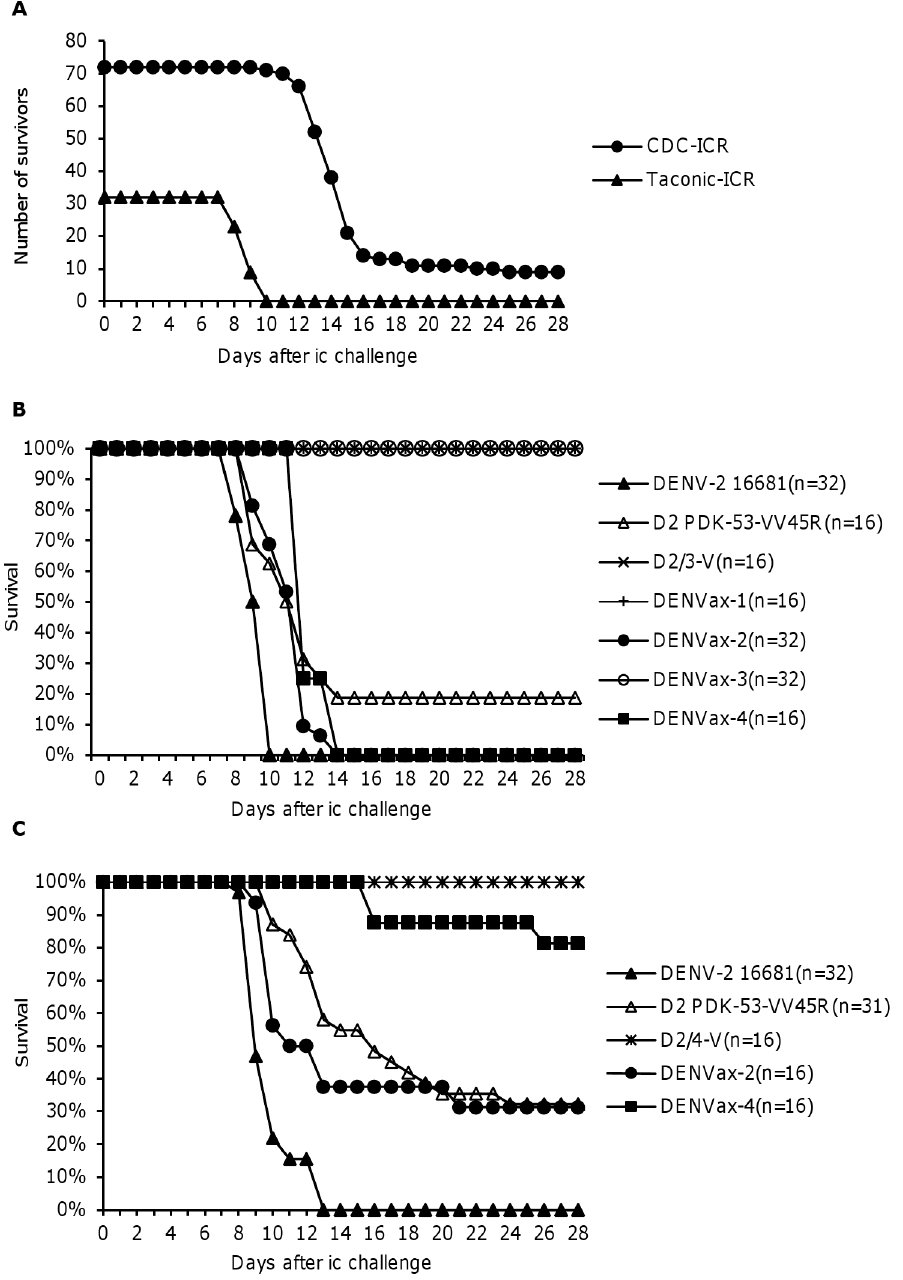
Figure 4. Neurovirulence in newborn mice. Pooled results of numerous experiments summarizing the neurovirulence of wt DENV-2 16681 virus in CDC-ICR ( n =72) and Taconic-ICR ( n =32) newborn mice challenged ic with 10 4 pfu of the virus (A). Neurovirulence of DENVax MVS tested in Taconic-ICR mice with a dose of 10 4 pfu (B) or 10 3 pfu (C). The numbers of animals tested per group in one experiment (n=16) or two pooled experiments (n=31 or 32) are